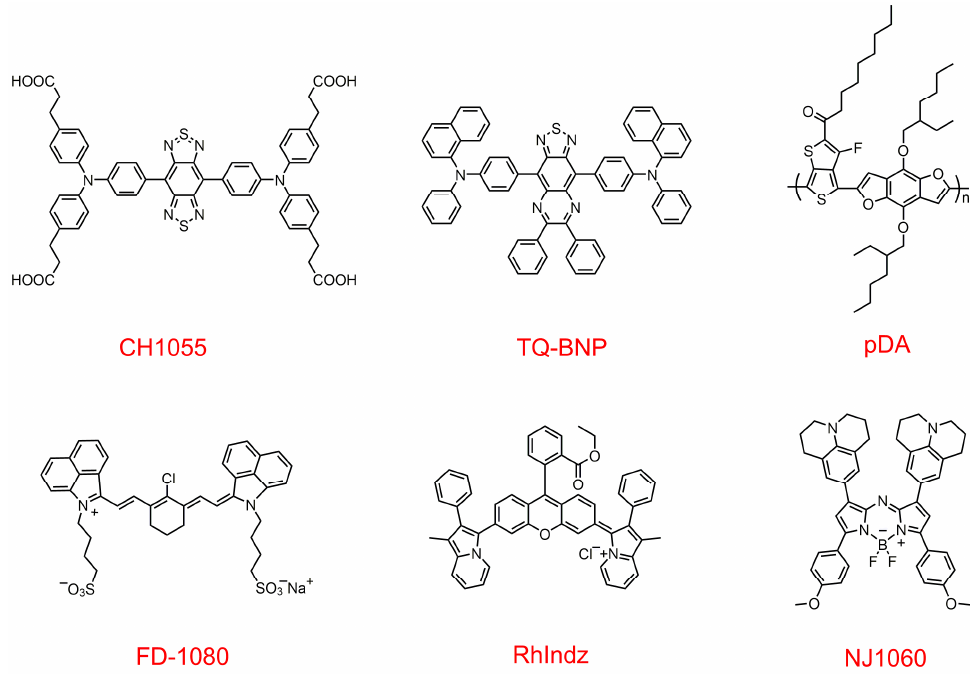
Figure 1. Chemical structures of CH1055, TQ-BNP, pDA, FD-1080, Rhlndz, and NJ1060.